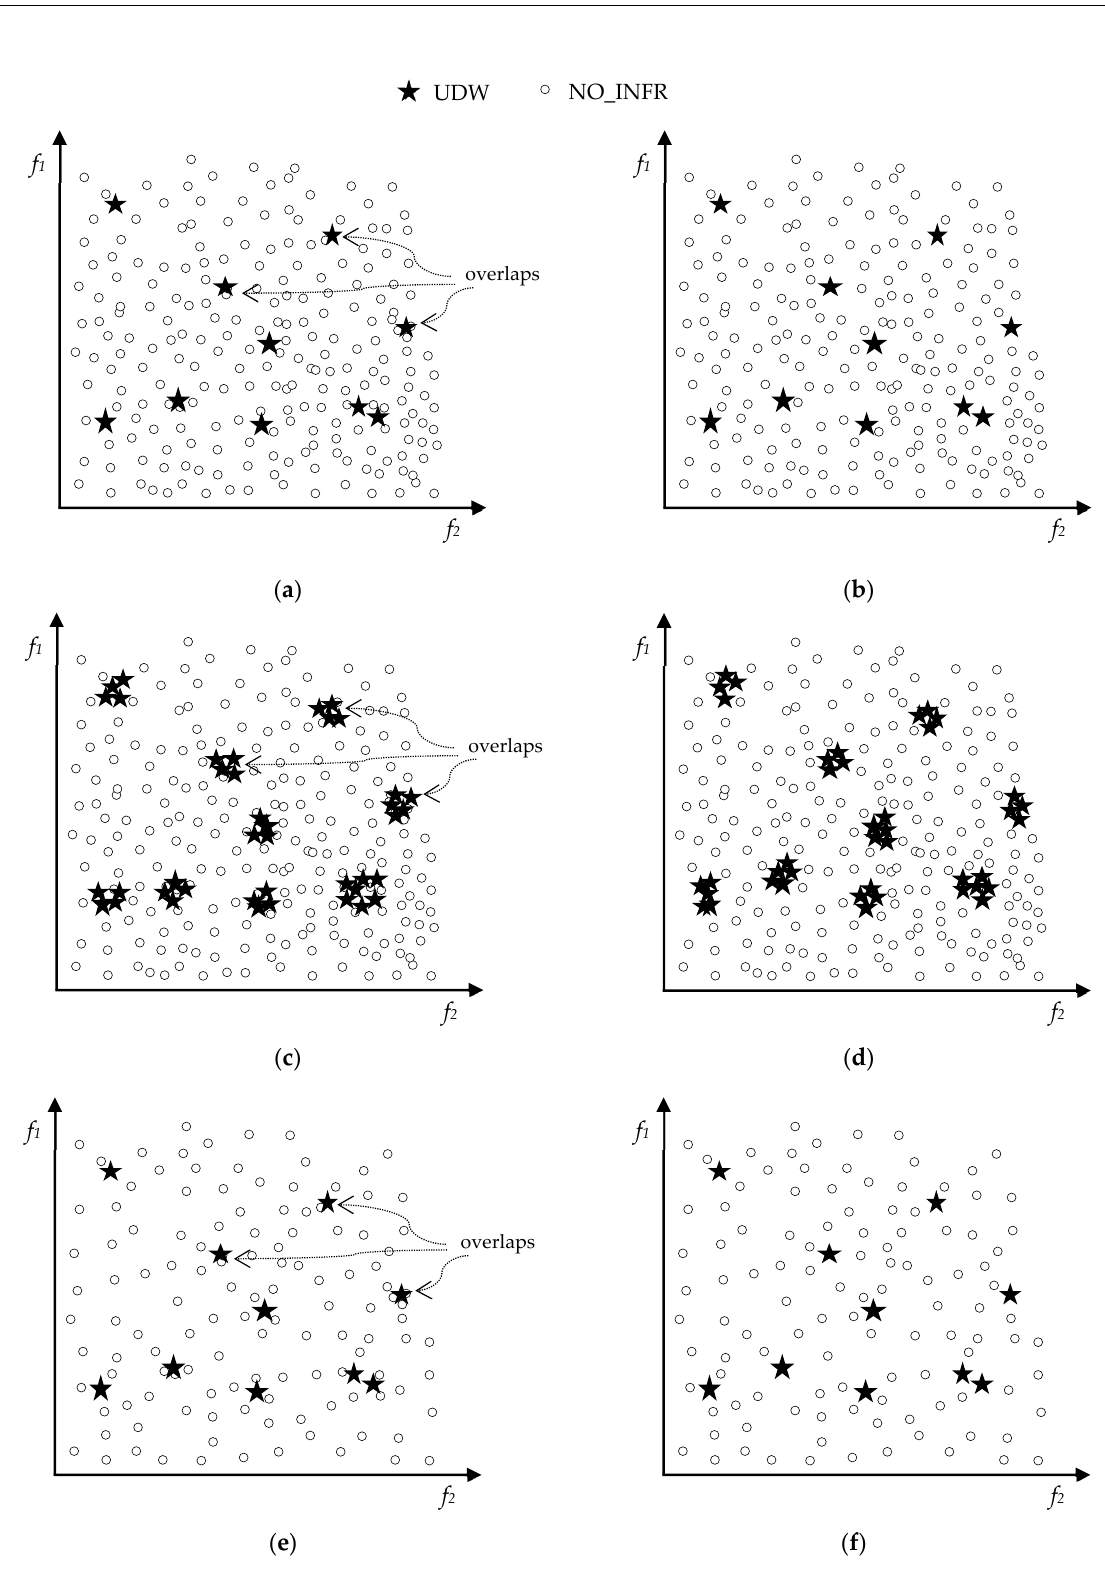
Figure 2. UDW training data class distributions in the dataspace: ( a ) final dataset (FD); ( b ) final dataset with applied class overlap removal (FD_COR); ( c ) final dataset with applied random over- sampling (FD_ROS); ( d ) final dataset with applied class overlap removal and random oversampling (FD_COR_ROS); ( e ) final dataset with applied random undersampling (FD_RUS); and ( f ) final dataset with applied class overlap removal and random undersampling (FD_COR_RUS).